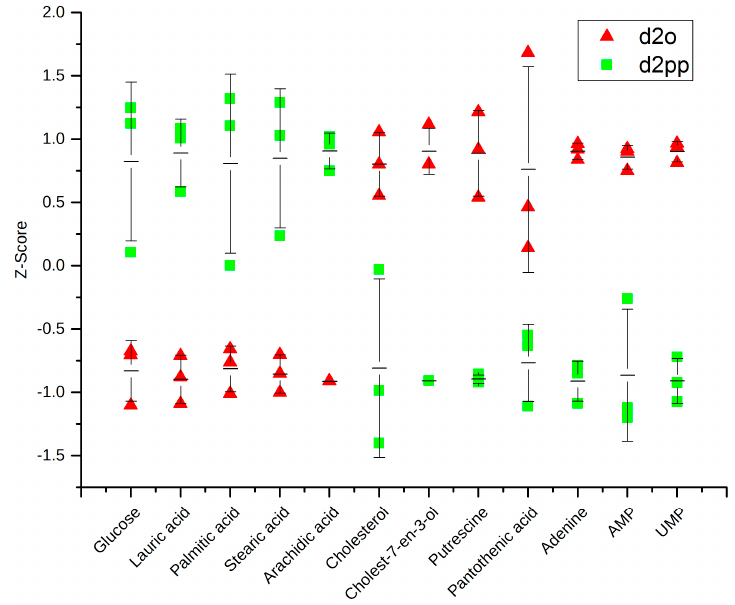
Figure 8. Dot plot with average and error bars of glucose; four free fatty acids; cholesterol and its derivative; putrescine; pantothenate; adenine, UMP and adenosine monophosphate (AMP) in groups d2o and d2pp.